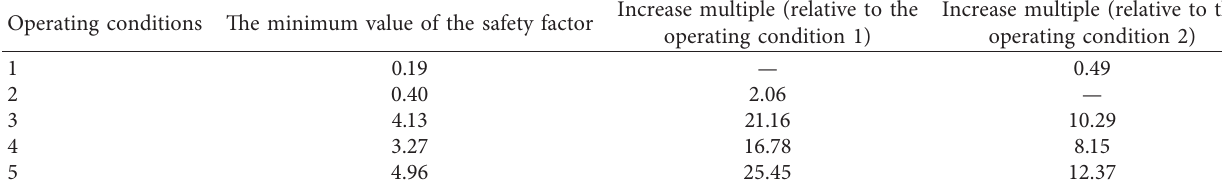
Table 7: Increase multiple of the minimum value of the safety factor.